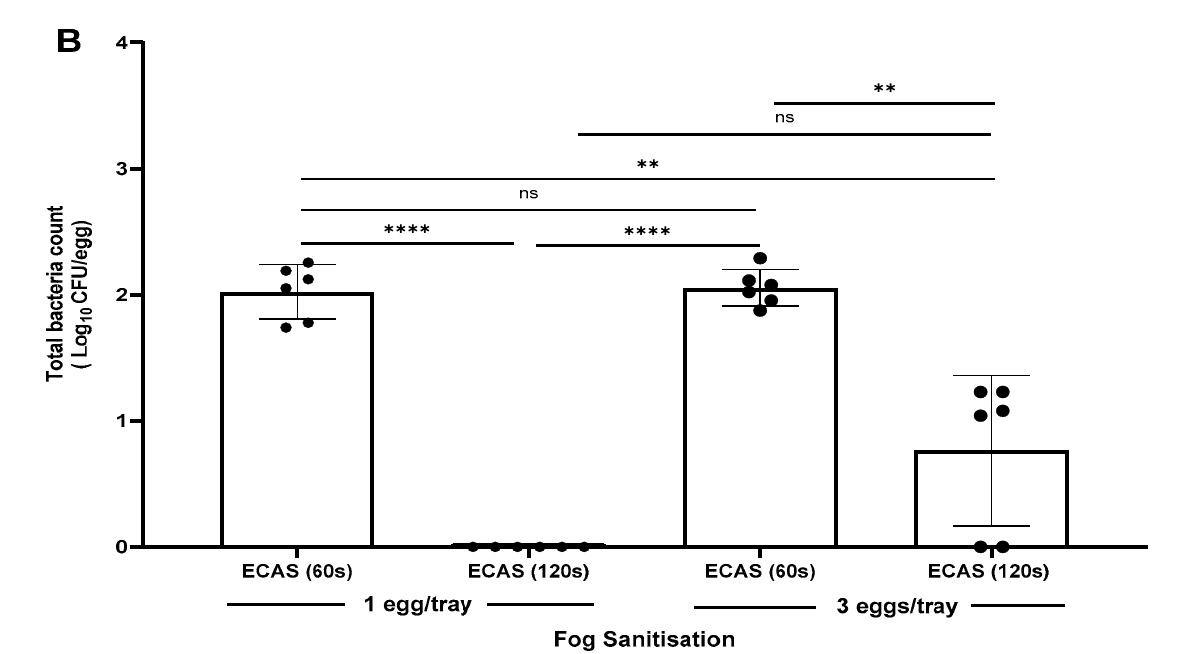
Figure 1. Effectiveness of sprayed and aerosolised ECAS on reduction of total bacterial load on egg surface. ( A ) Total bacterial load after the various sanitisation treatments. ( B ) Aerosolised ECAS sanitisation of individual (one egg/tray) and simultaneous (three eggs/tray) treated eggs for 60 s and 120 s. NaOCl—sodium hypochlorite (~200 mg/L FAC); ECAS—electrochemically activated solution (150 mg/L of FAC); ns—not significant; ** p < 0.01, **** p < 0.0001.